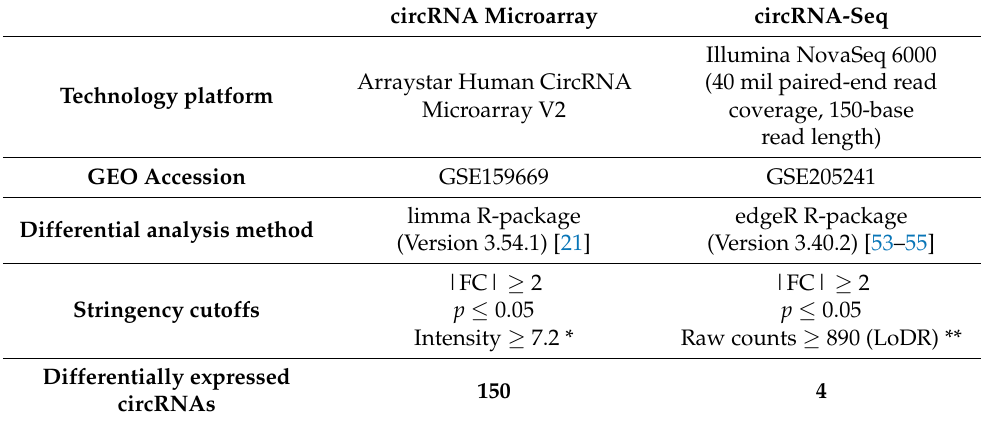
Table 8. Differentially expressed circRNAs by circRNA microarray and circRNA-seq. circRNA Microarray